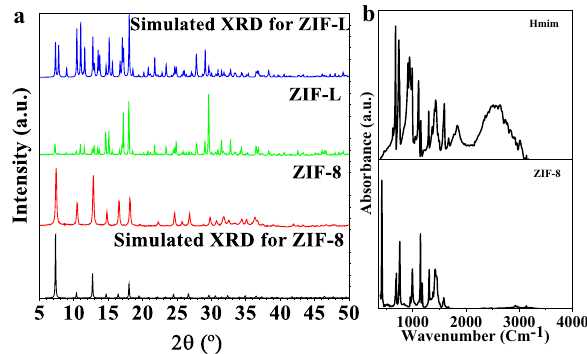
Figure 2. Characterization of ZIF-8 and ZIF-L using ( a ) XRD and ( b ) FT-IR spectra.